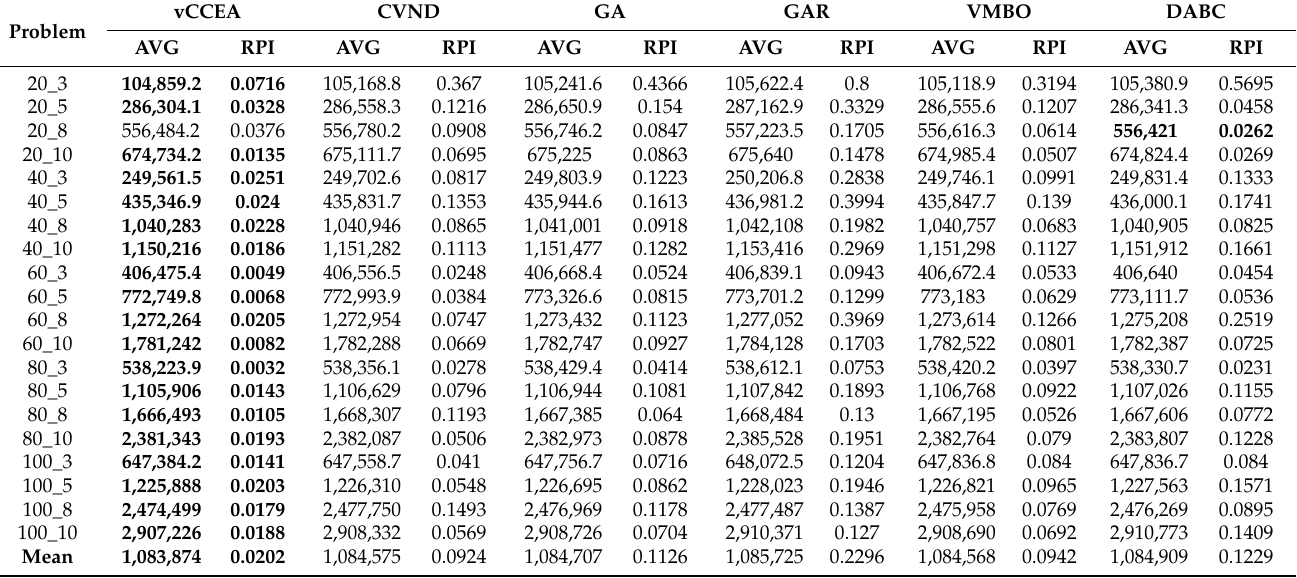
Table 7. Comparison results of vCCEA and other algorithms on β 2